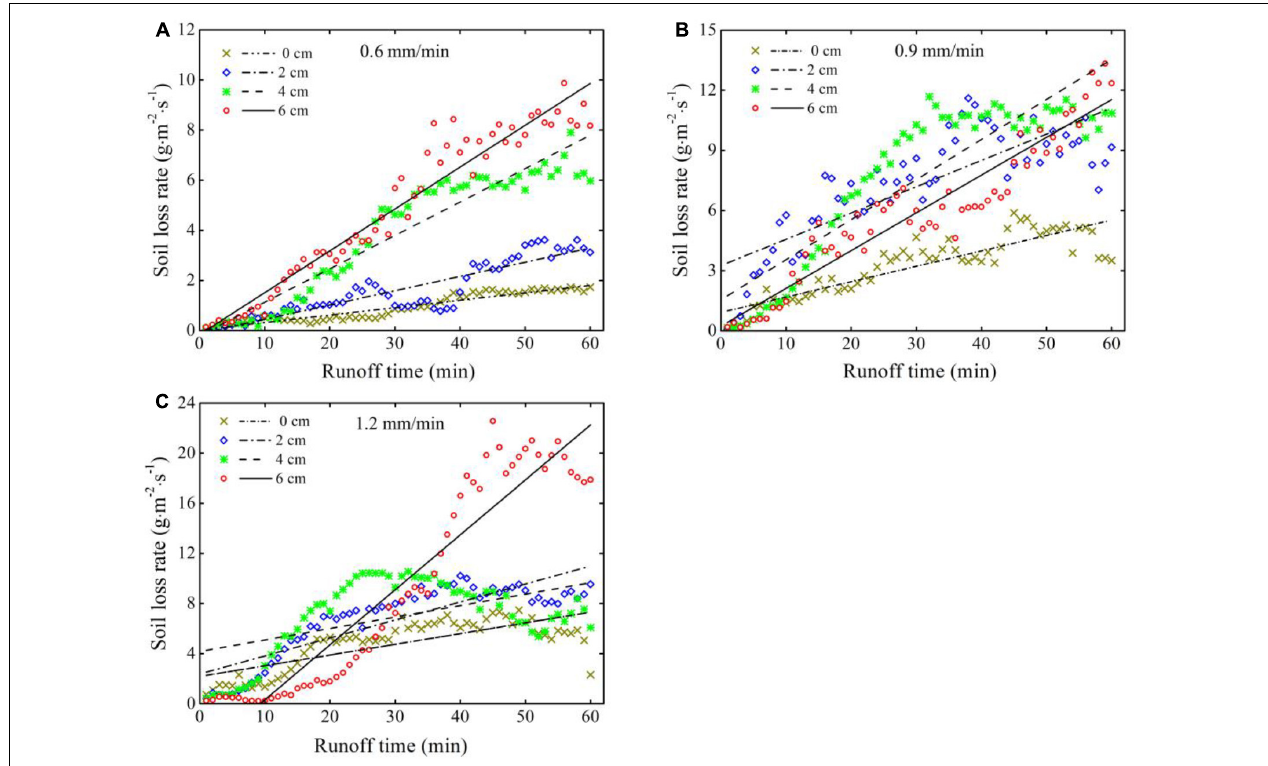
FIGURE 2 | The relationship between soil loss rate and runoff time over different thawed depth at 0.6 mm/min (A) , 0.9 mm/min (B) , and 1.2 mm/min (C) .